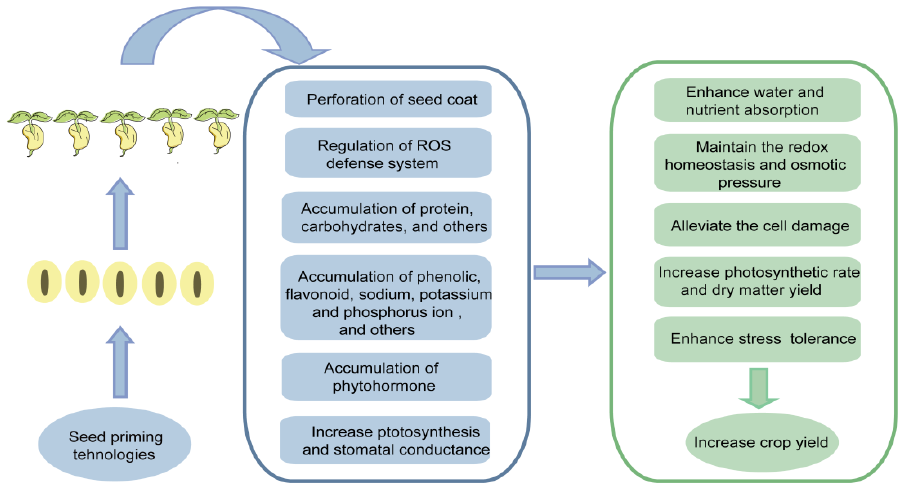
Figure 1. A schematic diagram describing the positive effect of seed priming